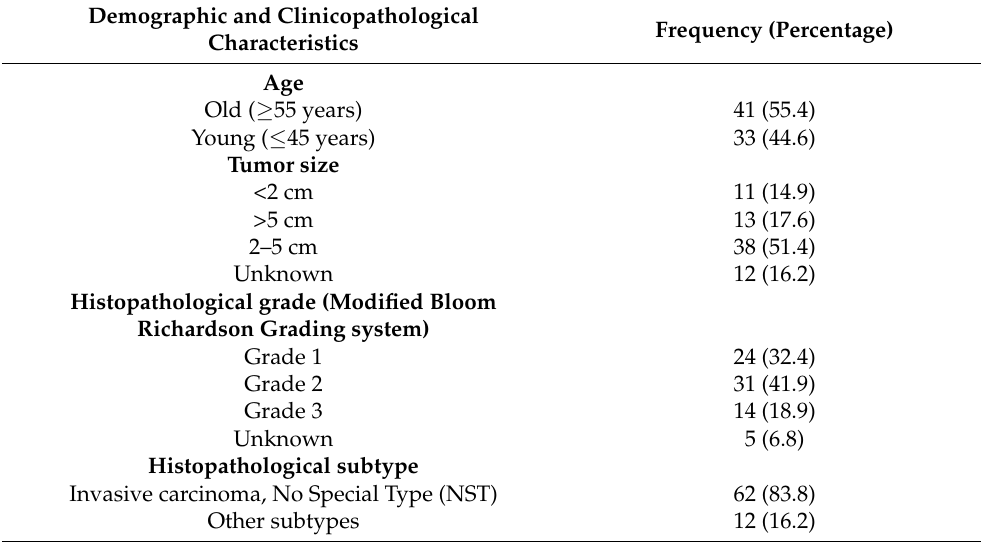
Table 5. Clinicopathological characteristics of 74 breast carcinoma cases stained with